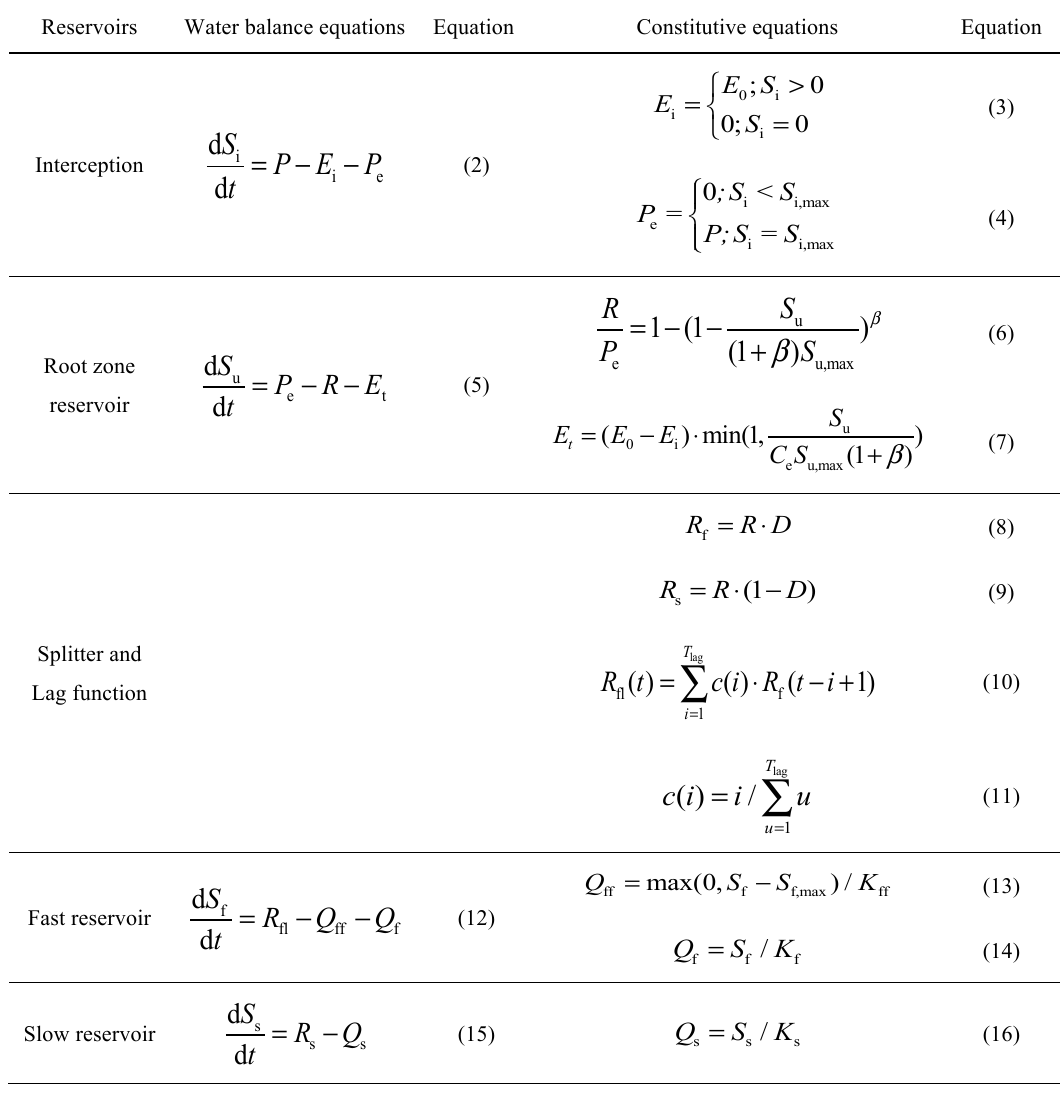
Table 2. Water balance and constitutive equations used in FLEX L . 660 Reservoirs Water balance equations Equation Constitutive equations Equation